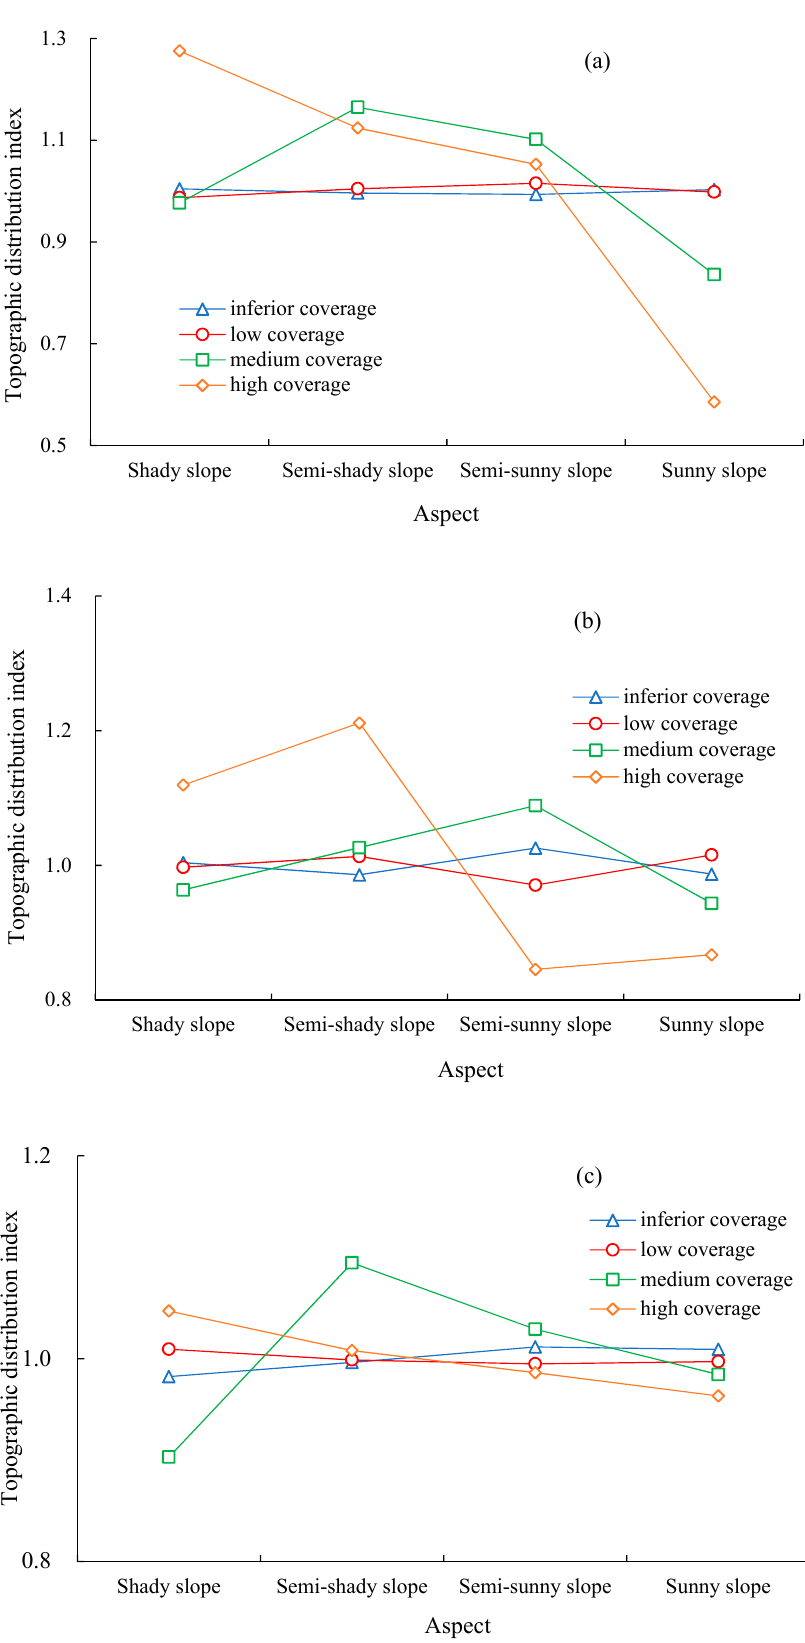
Figure 15. Variations in topographic distribution index and aspect in di ff erent FVC levels. ( a ) Bare Pisha sandstone; ( b ) Sand-covered Pisha sandstone; ( c ) Soil-covered Pisha